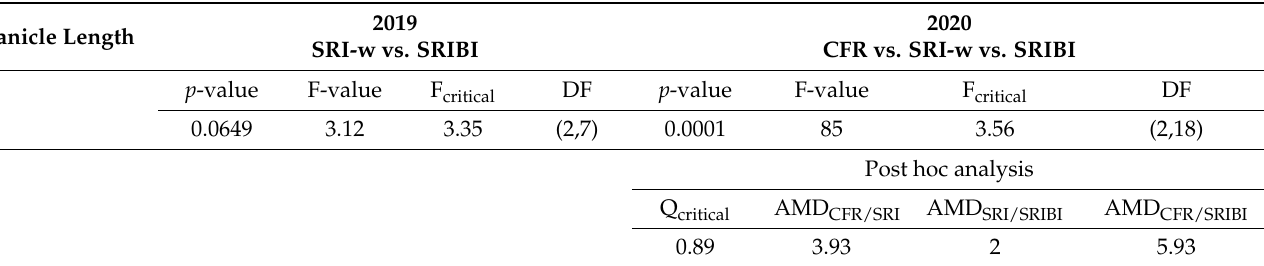
Table 7. Parameters from ANOVA statistical analysis for panicle length